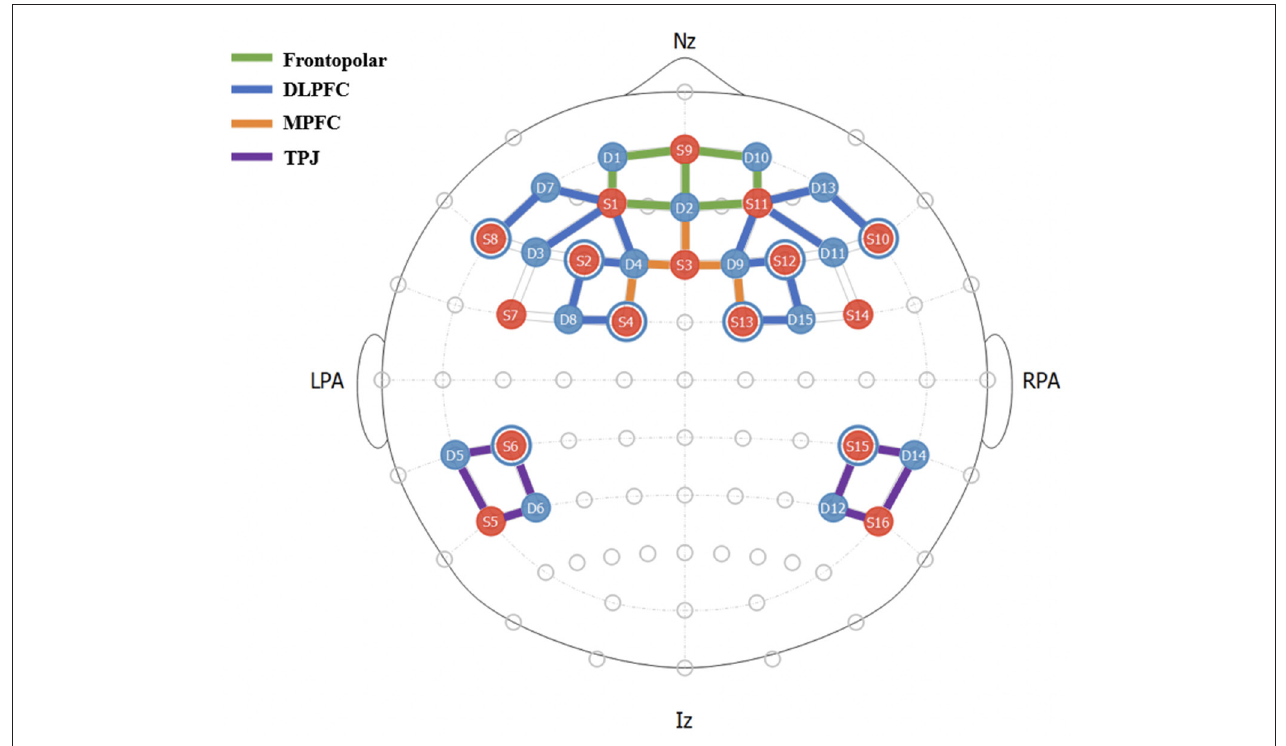
FIGURE 3 | fNIRS Montage and ROI Mappings. Each channel consists of a source-detector (S#-D#) pair, represented by colored lines.